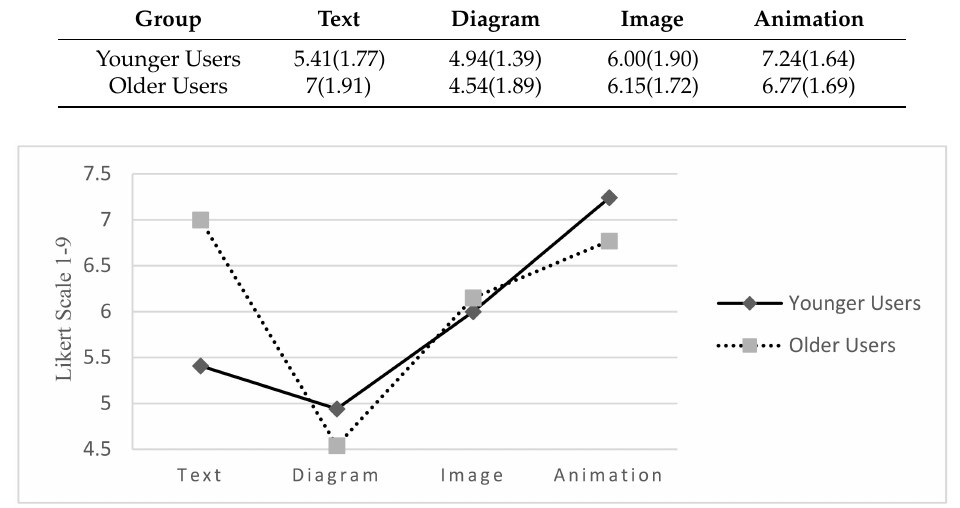
Figure 12. Comparison of affective valences of the four